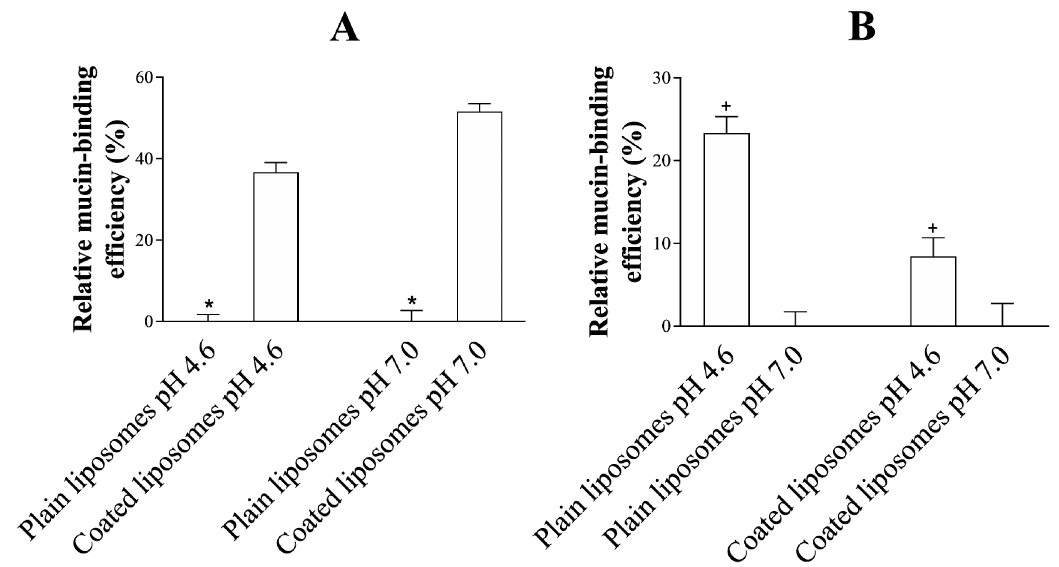
Figure 5. Relative mucin-binding e ffi ciency (%) of ( A ) coated liposomes compared to plain liposomes at each pH, and ( B ) each liposomal formulation at a pH of 4.6 compared to a pH of 7.0.* Represents statistical di ff erence between the two di ff erent liposomal formulations at the same pH. + Represents statistical di ff erence between di ff erent pH conditions for the same liposomal formulation.